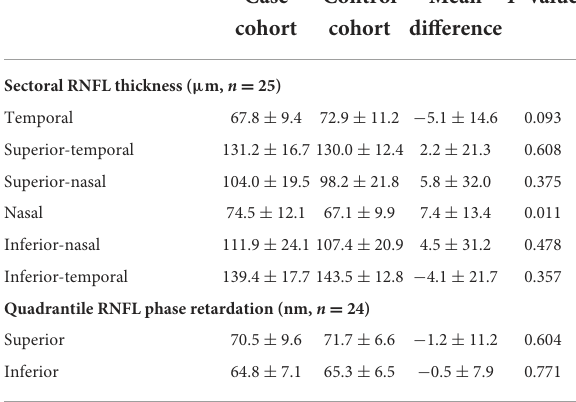
TABLE 4 Secondary retinal nerve fiber layer (RNFL) imaging